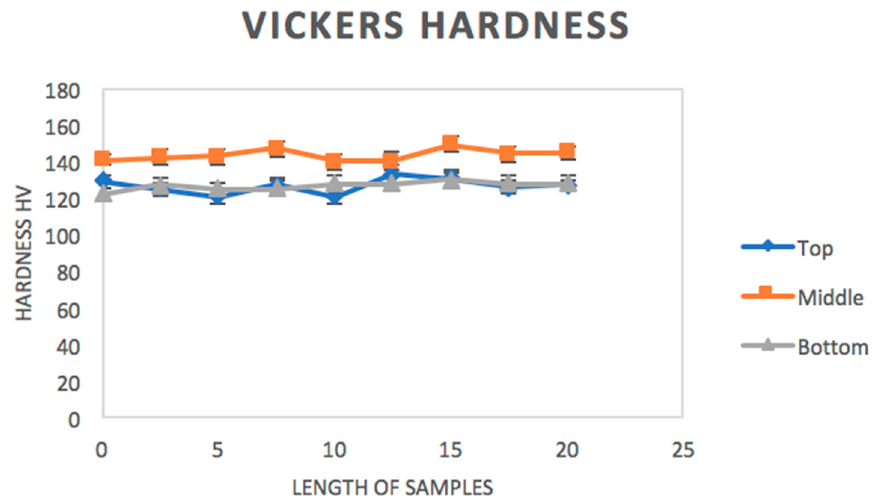
Figure 5. Graph of hardness versus position from the weld centre for Al 7075 alloy. FS welded plates after heat treatment at 628 °C.